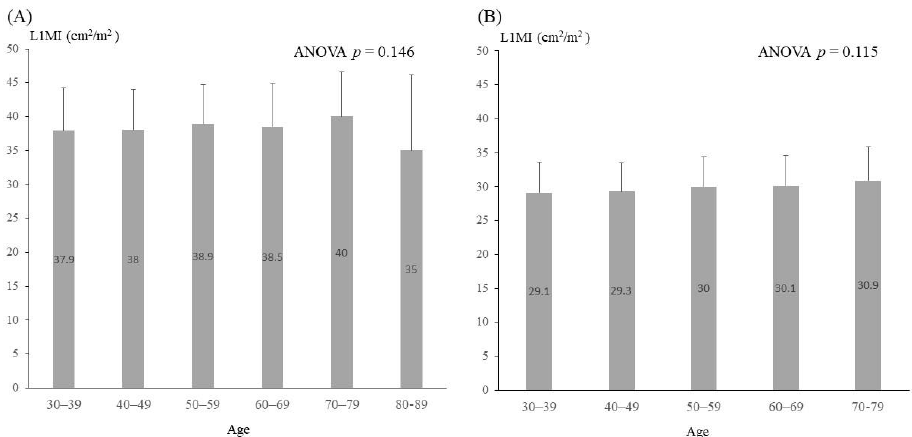
Figure 1. Histogram of mean L1MI by age decades in the study population. ( A ) Male ( B ) Female. Abbreviation: L1MI: the ratio of muscle surface (cm 2 ) at L1 to height squared (m 2 ). The numbers in the boxes are mean values. Vertical lines represent standard deviations.